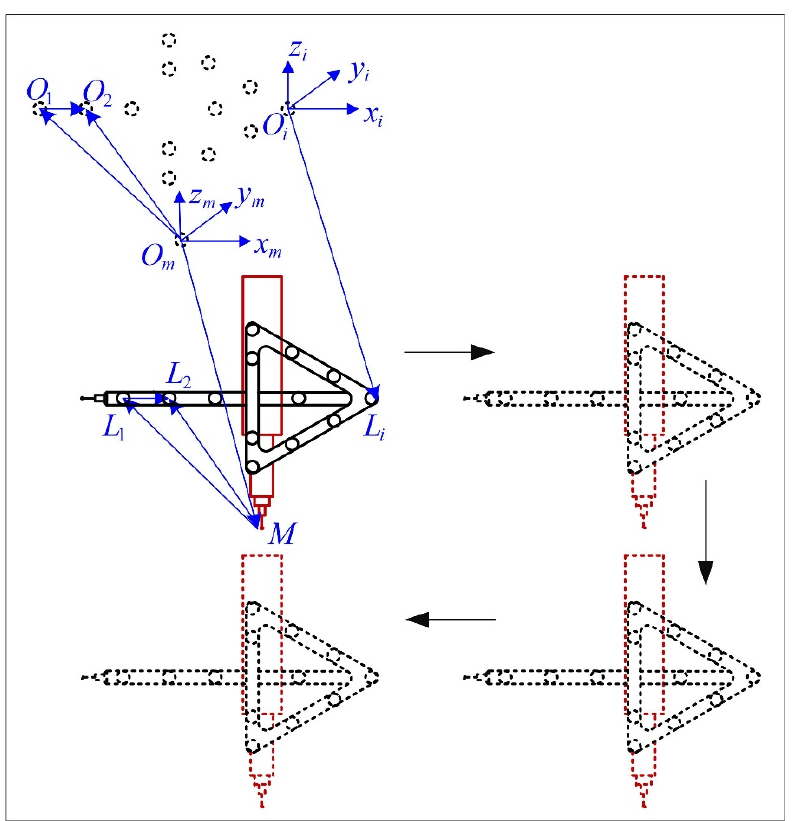
Figure 2. The establishment of the CMM machine coordinate system and all the control point coordinate systems. The control point position calibration problem is converted to determining the relative positions of the origins of control point coordinate systems.